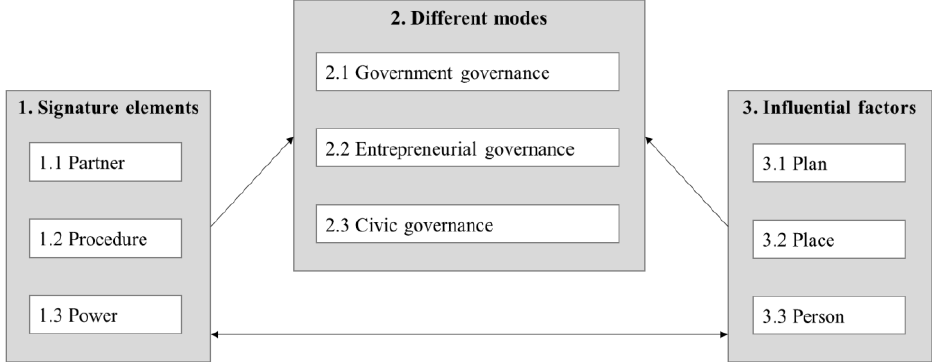
Figure 4. Research framework.